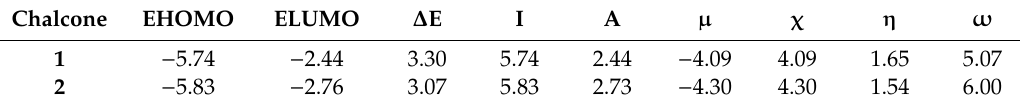
Table 2. Quantum chemical parameters for optimized geometries of chalcones in (eV). Chalcone EHOMO ELUMO